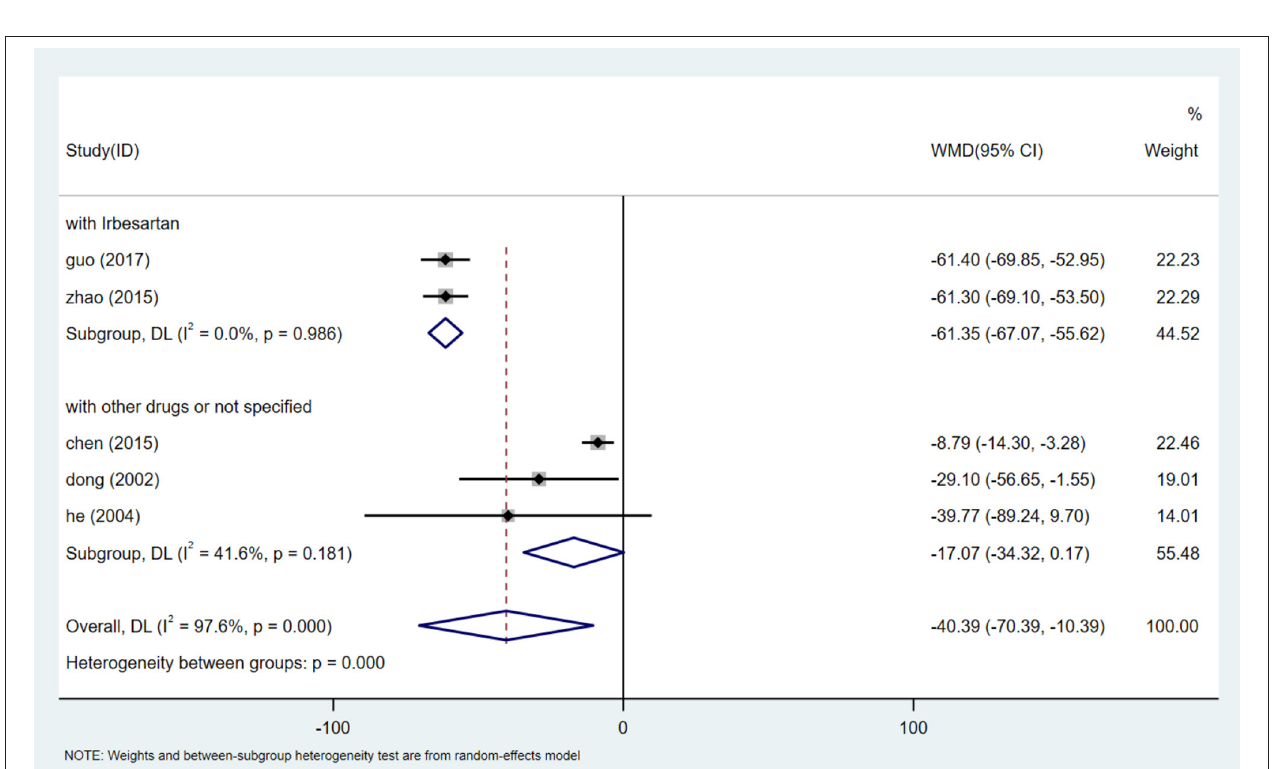
FIGURE 8 | Subgroups analysis of